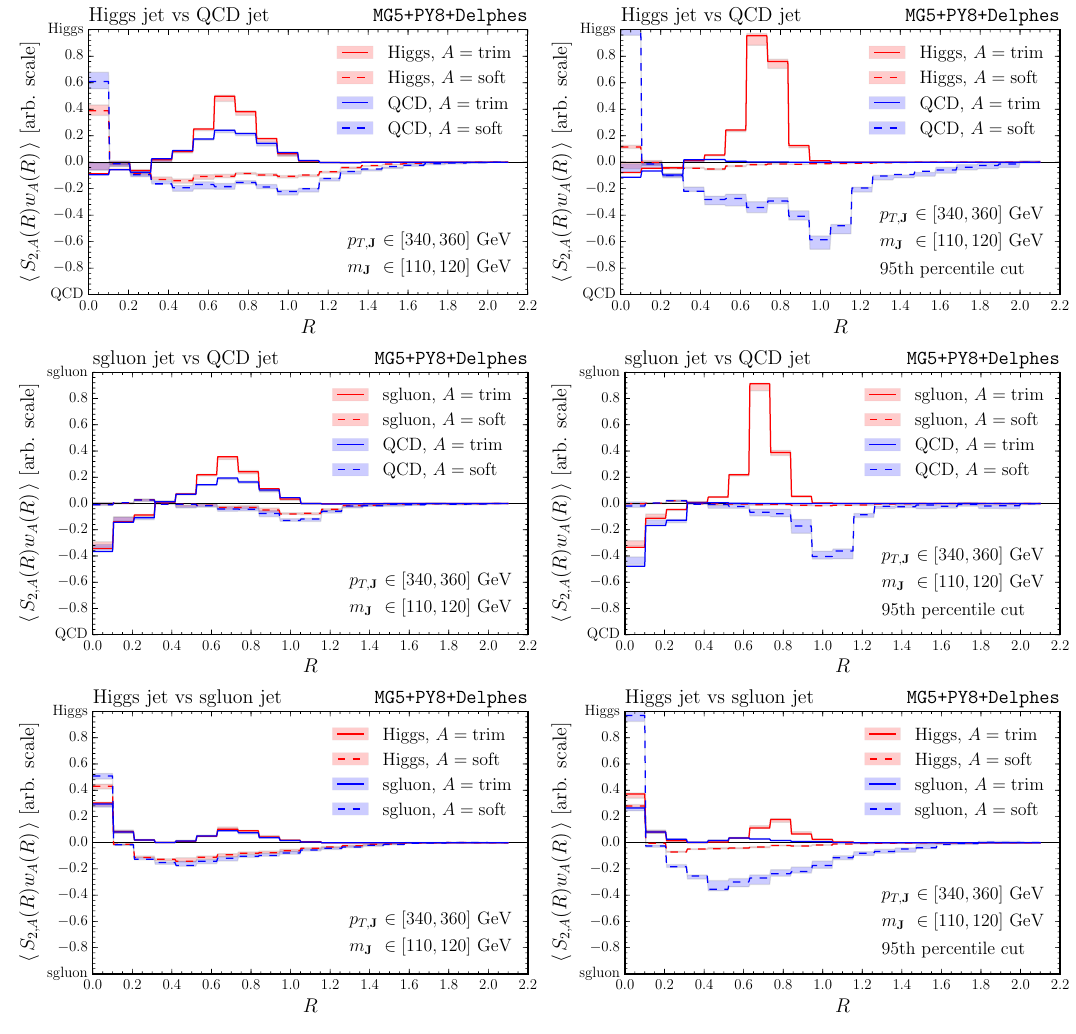
Figure 16 . The distribution of the mean value w soft ( R ) (dashed). We show the (cid:1) i vs. QCD jet (center), and Higgs jet vs. sgluon jet (bottom) classi(cid:12)cations. In the right (cid:12)gure, we additionally demand that ^ y h of the Higgs jet and ^ y QCD of the QCD jet are larger than their 95th percentile respectively. We show their statistical uncertainty from the training samples as colored